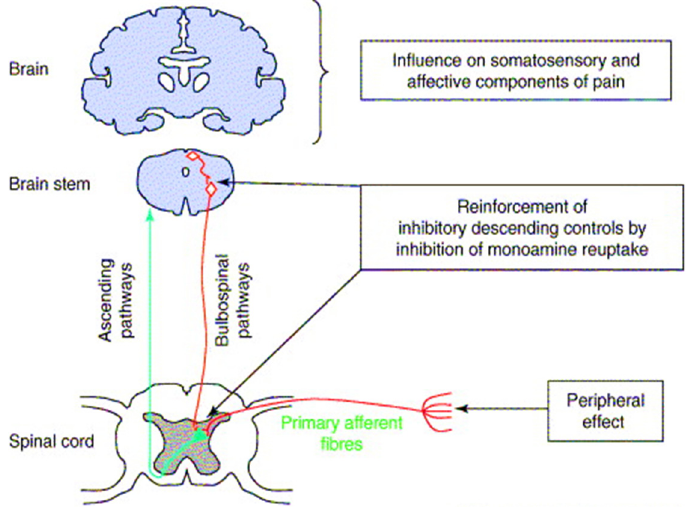
Figure 1. The mechanism of action of antidepressants. Reprinted from Micó et al., 2006 with permission from the Trends in Pharmacological Sciences, 2006. Copyright (2022), Elsevier, Amsterdam, The Netherlands [67] .